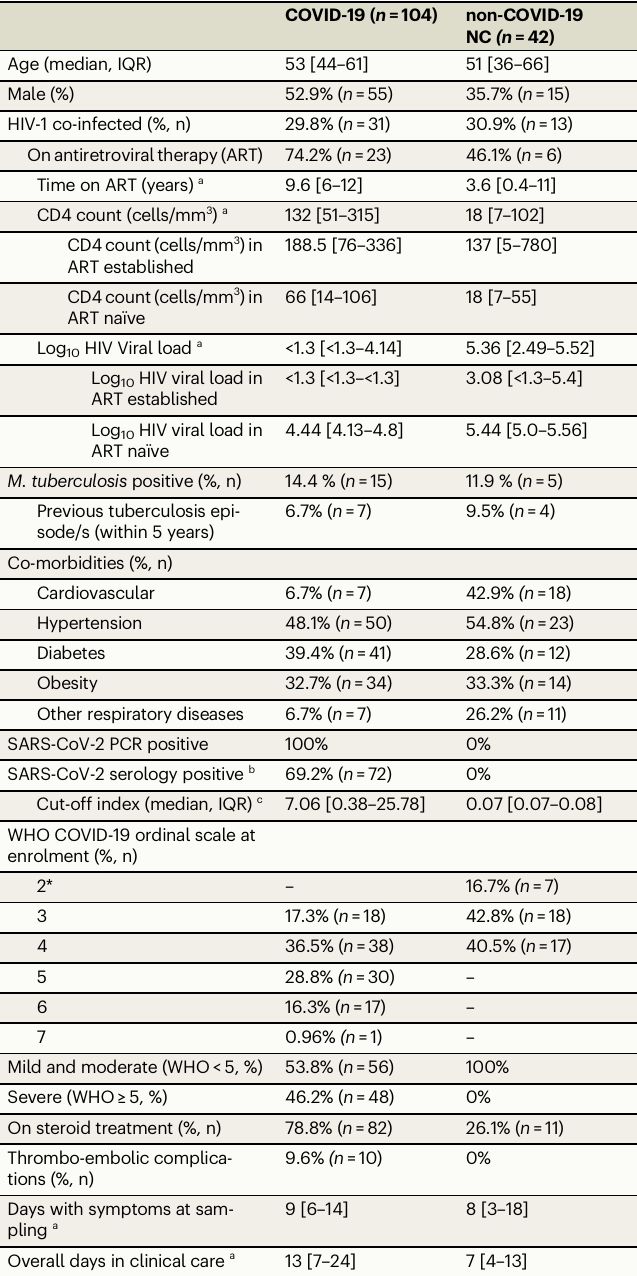
Table 1 | Clinical characteristics of COVID-19 versus hospita- lized non-COVID-19